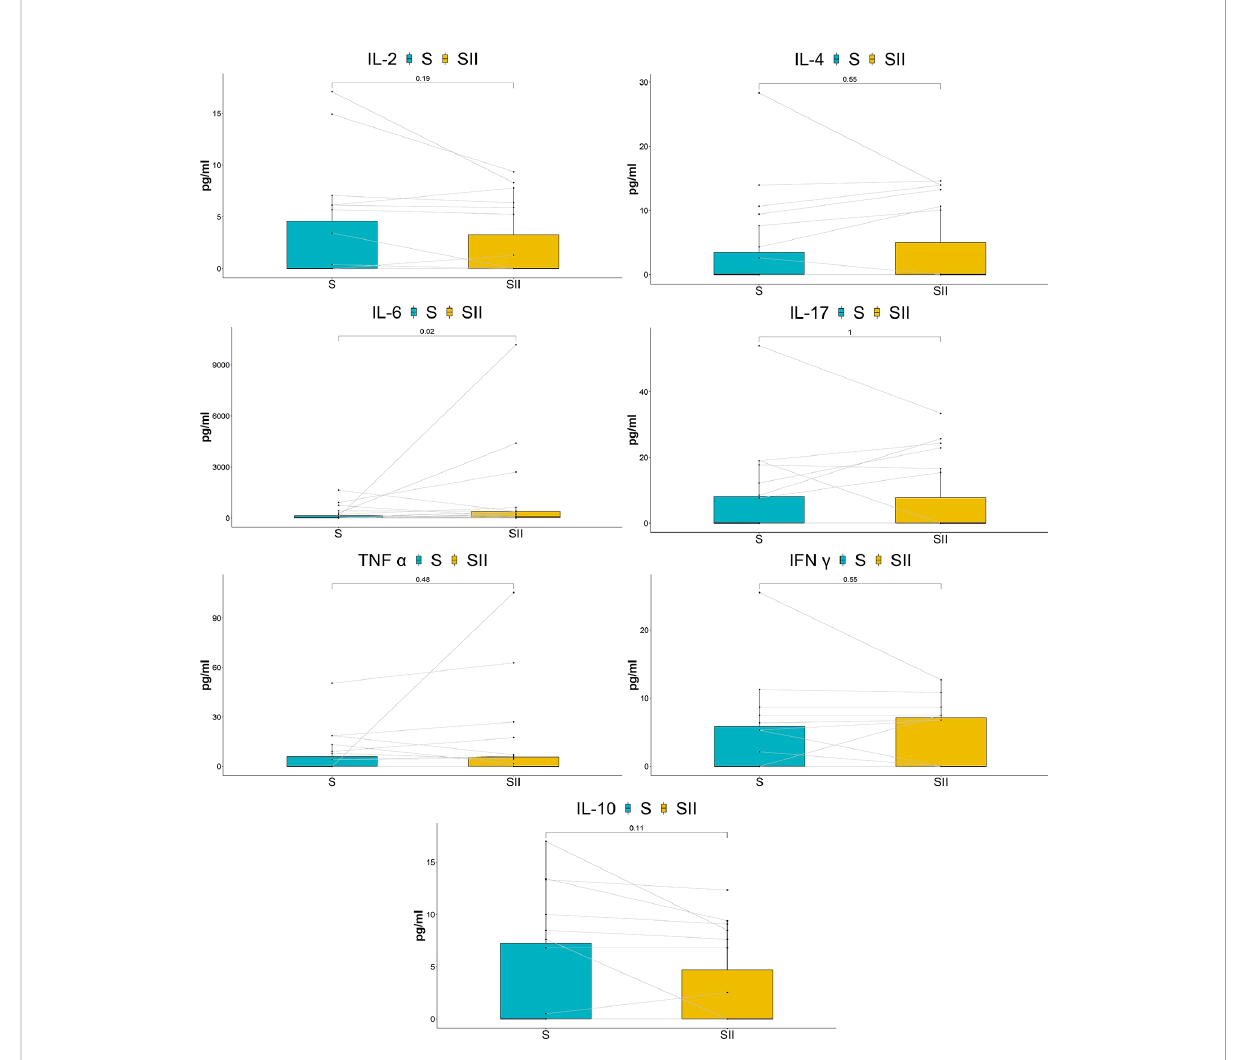
FIGURE 5 Comparison of cytokine concentrations between baseline and after treatment for 7